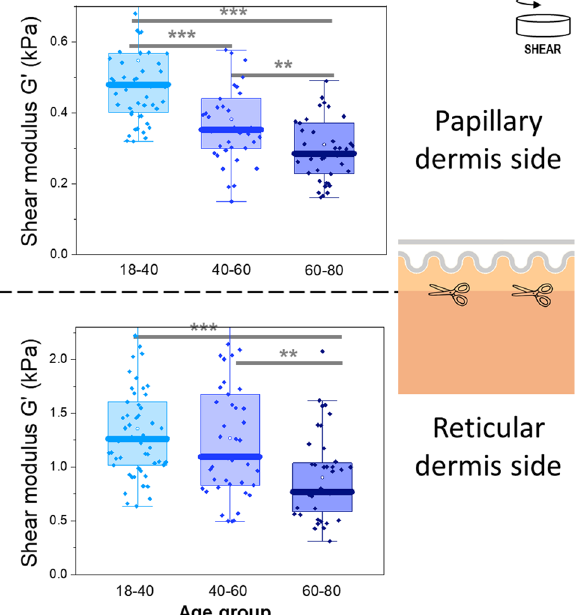
Figure 3. Storage modulus G ′ (kPa) as a function of age group for the papillary dermis (top) and reticular dermis (bottom) for photoprotected mammary skin. The epidermis layer has been removed prior to measurements. One dot represents one skin sample. Multiple samples were obtained for each donor. ** p < 0.01, *** p <